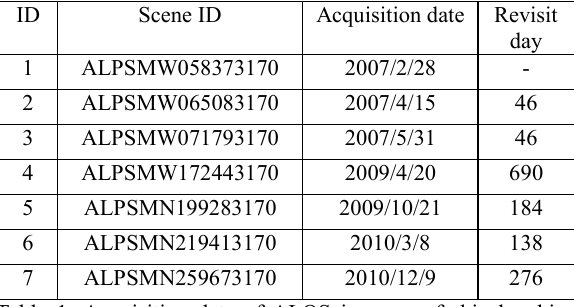
Table 1. Acquisition date of ALOS imagery of ship breaking